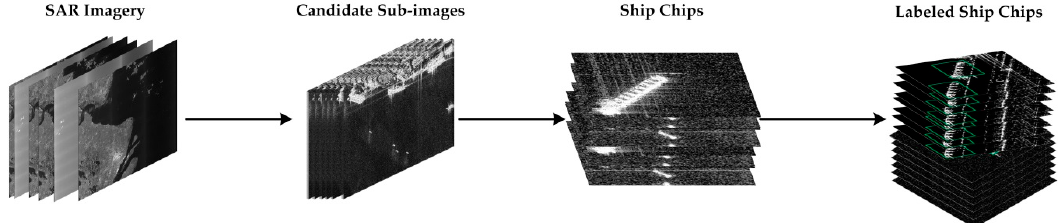
Figure 5. The procedures for the construction of the labeled ship chips.